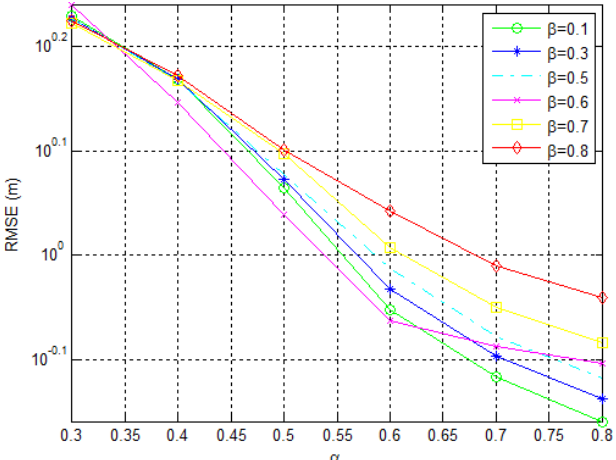
Figure 4. RMSE (m) dependency on α for different values of β